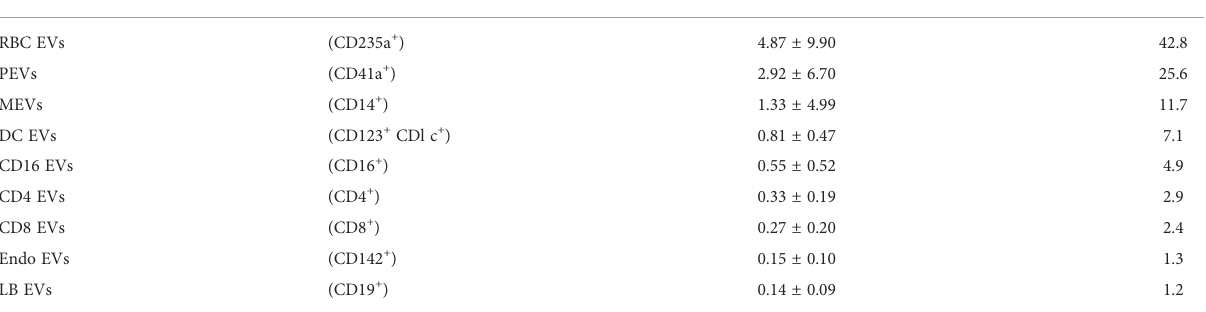
TABLE 1 Cellular origin of EVs from the plasma of 22